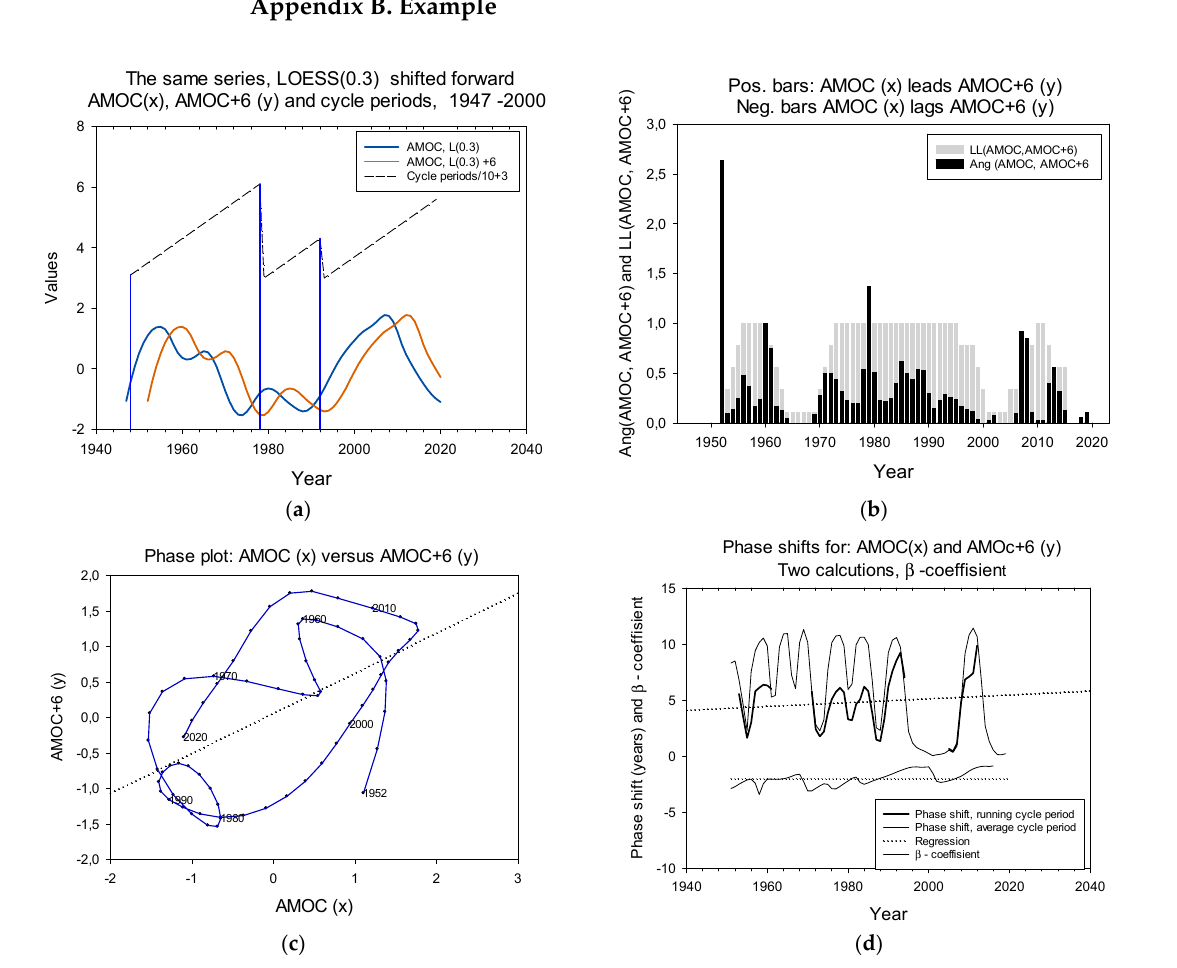
Figure A3. Example: AMOC LOESS(0.3)-smoothed (x) and shifted forward six years (y). ( a ) AMOC time series, original (blue) and shifted 6 years forward. The original annual AMOC series has been LOESS(0.3)-smoothed. The zigzag curve indicates the length of years found by the cumulative angle method. ( b ) LL relations between AMOC original and AMOC shifted 6 years forward, LL(AMOC, AMOC+6). The black bars show Ang(3); that is, LL relation over three consecutive observations in the paired time series. The grey bars show LL(9); that is, the relation between positive and negative angles over 9 consecutive observations. ( c ) Phase plot for the pairs AMOC and AMOC+6. Note that most rotations are counterclockwise (positive, +) showing that AMOC leads AMOC +6. ( d ) Phase shifts calculated relative to moving cycle period and with average cycle period. Average cycle pe- riod is about 6 years, corresponding to the six years design phase shift. Lowe curve shows moving β -coefficient. References 1.